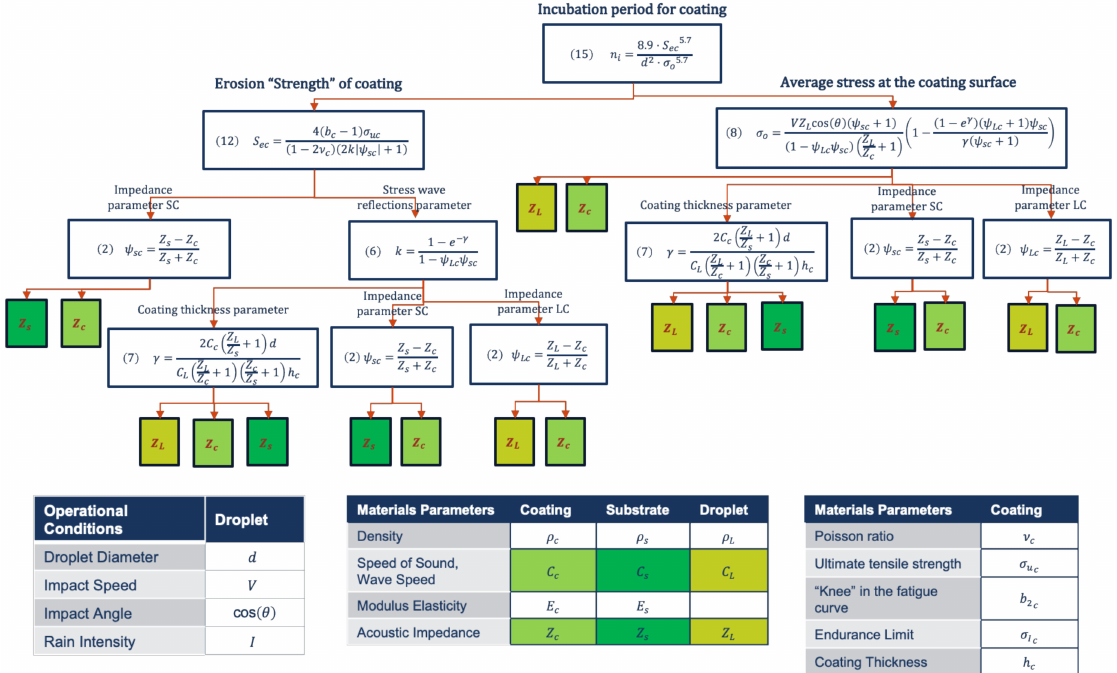
Figure 5. Map of impedance values as input data for the wear erosion lifetime modelling, implemented equations in [15]. Diagram of liquid, coating and substrate material impedances and operational parameters a ff ecting rain erosion